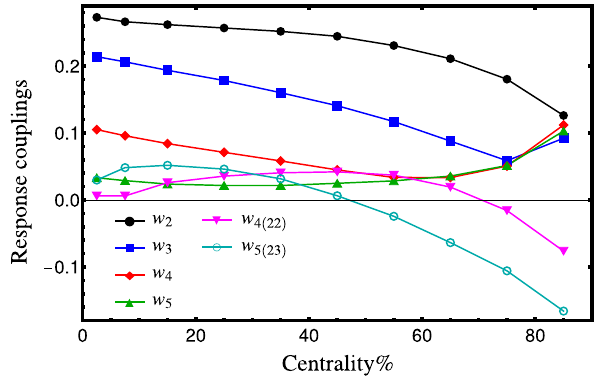
Fig. 3 Linear and nonlinear hydrodynamic response couplings obtained by comparing initial and final state normalized cumulants